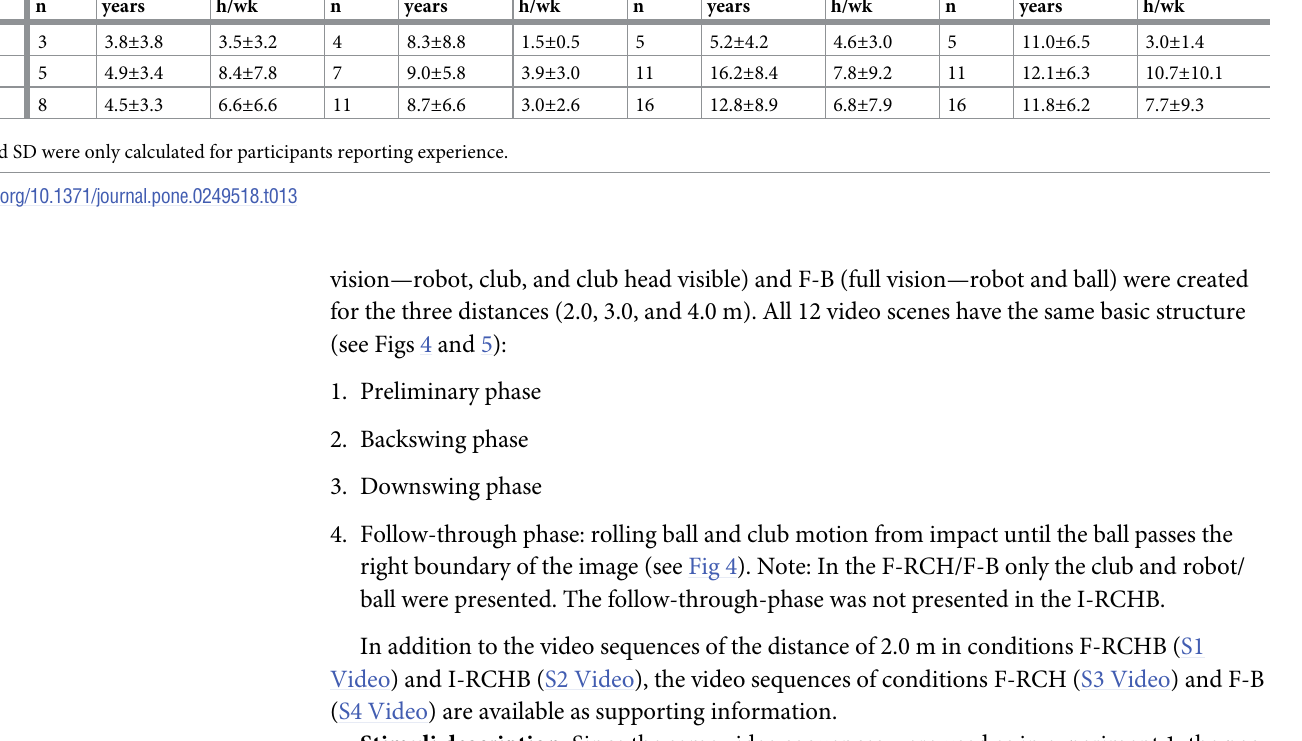
Table 13. Experience in selective sports and computer games (mean ± SD). Golf, field hockey and similar